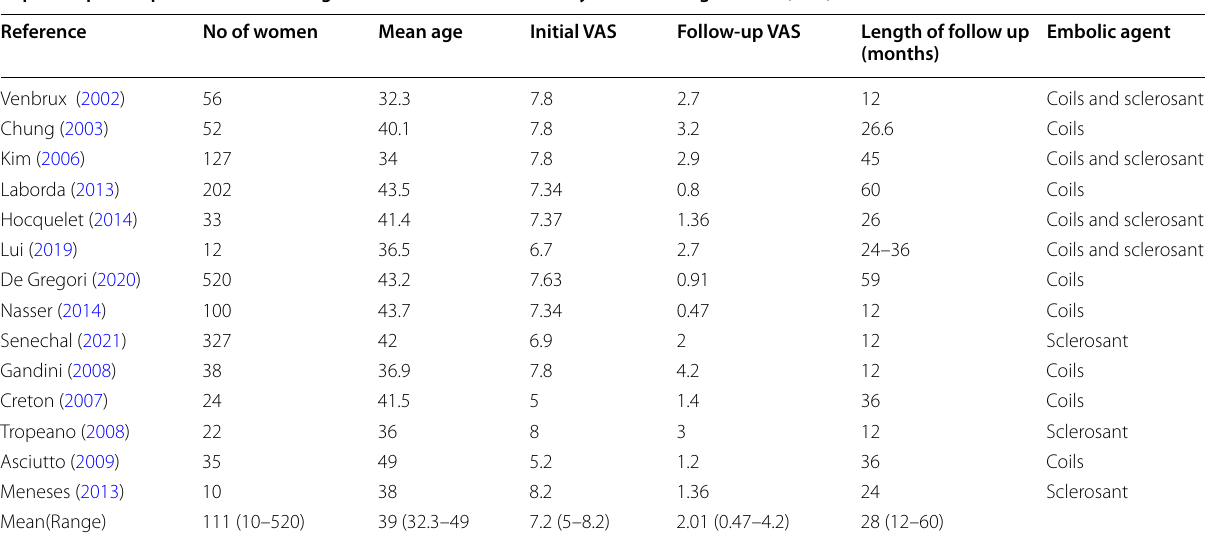
Table 2 Illustrates reported improvement in pain following ovarian vein embolization as measured by visual analogue score (VAS)